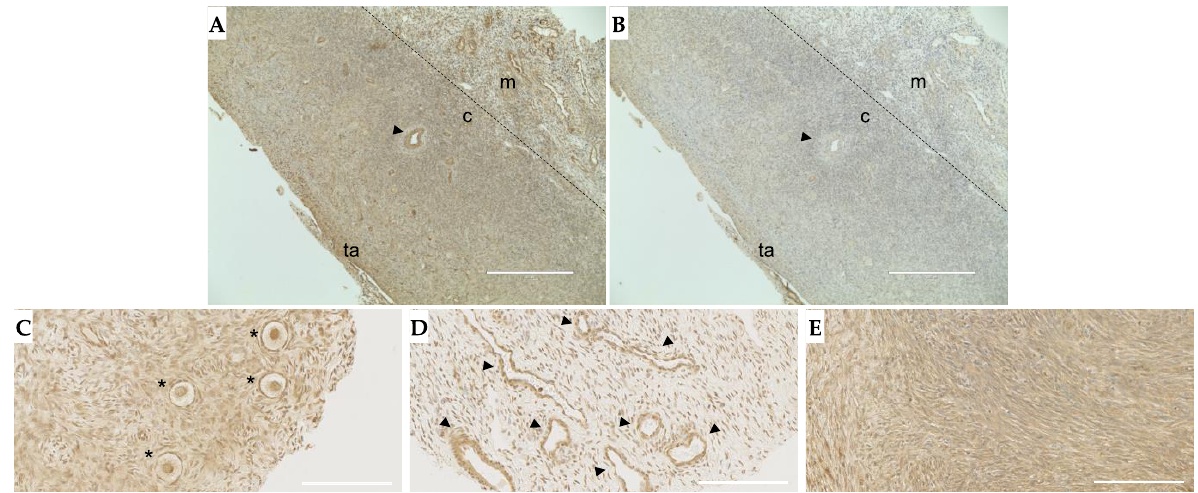
Figure 5. TGFβ3 is found throughout the ovarian stroma, within the follicles and around blood vessels. ( A ) Tissue section with specific staining throughout the stroma and around key structures in the ovary. ( B ) IgG negative control; ( C ) primor- dial follicles (asterisks); ( D ) blood vessels (arrowheads); ( E ) dense stroma. Panels ( A , B ) are representative histological sections performed in n = 6 patients, and ( C – E ) are cores from the TMA with representative images shown. Arrowheads: blood vessels, ta: tunica albuginea, c: cortex, m: medulla, asterisk: primordial follicles. ( A , B ) Scale bar = 400 µm; ( C , D ) scale bar = 100 µm. 100 µ